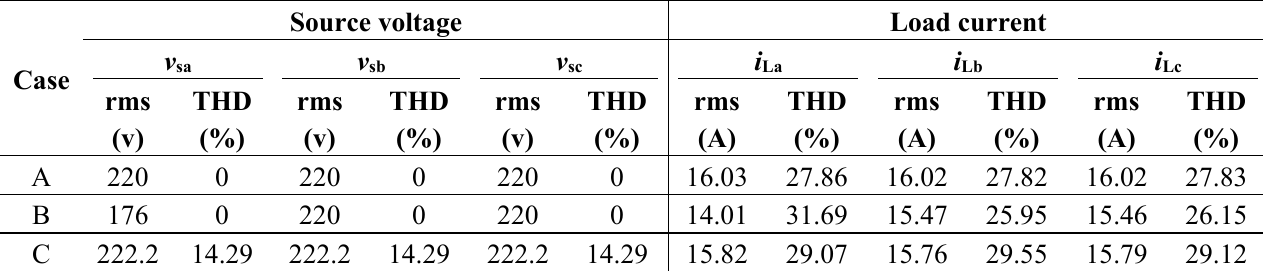
Table 4. Grid voltage, load current and THD under various grid voltage conditions [10].